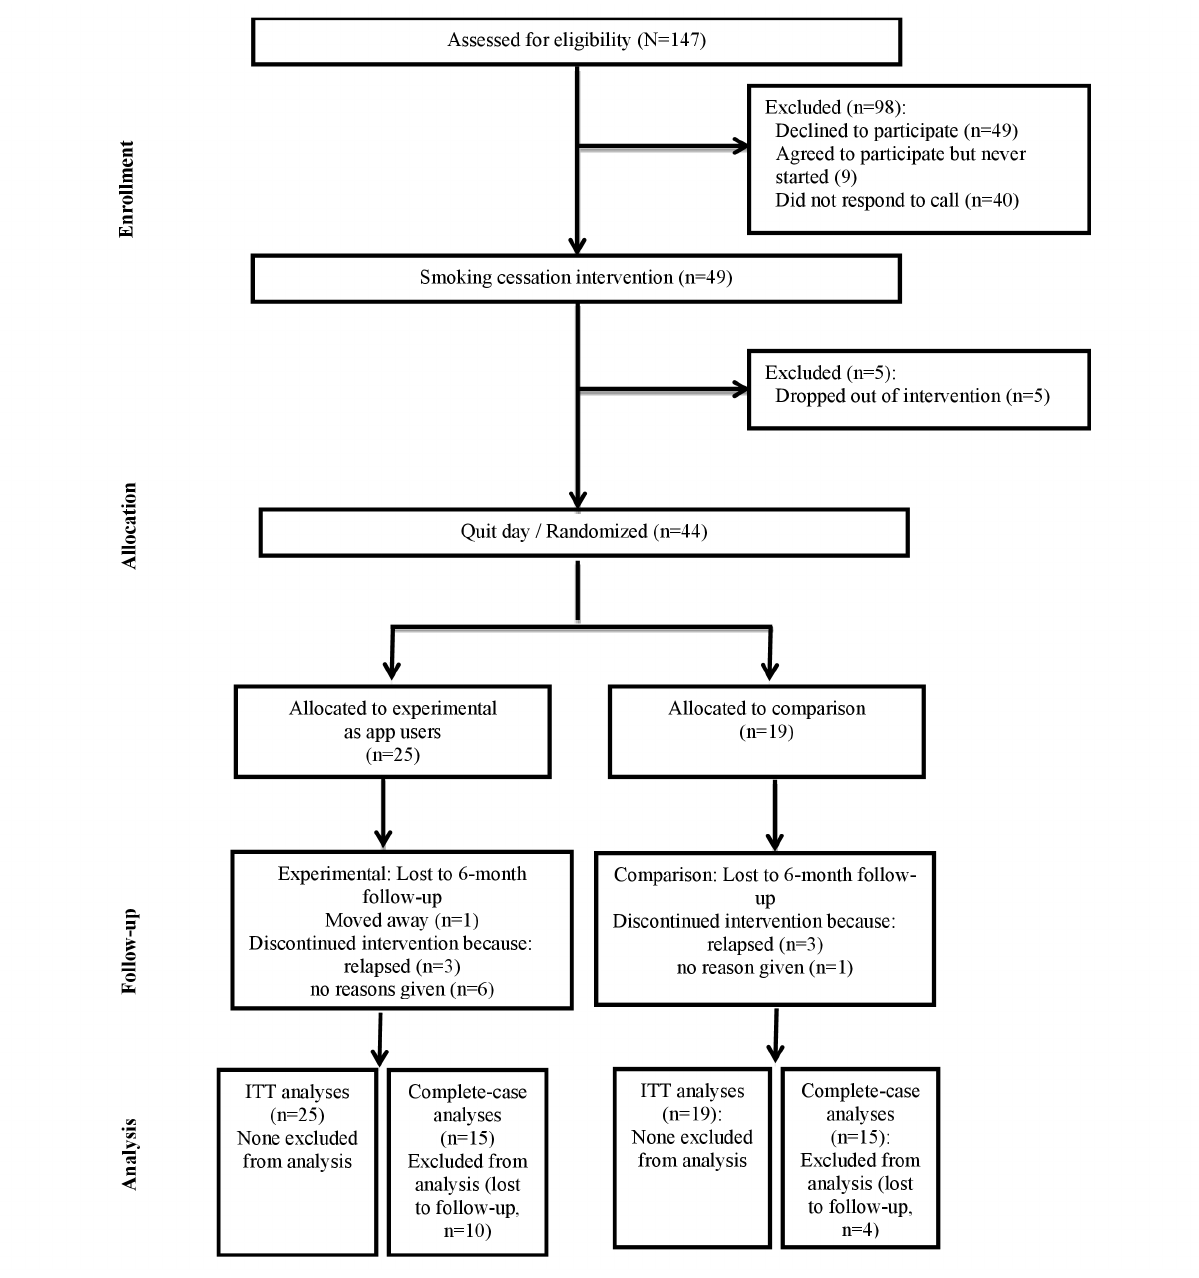
Figure 1. Participant flow chart. ITT: